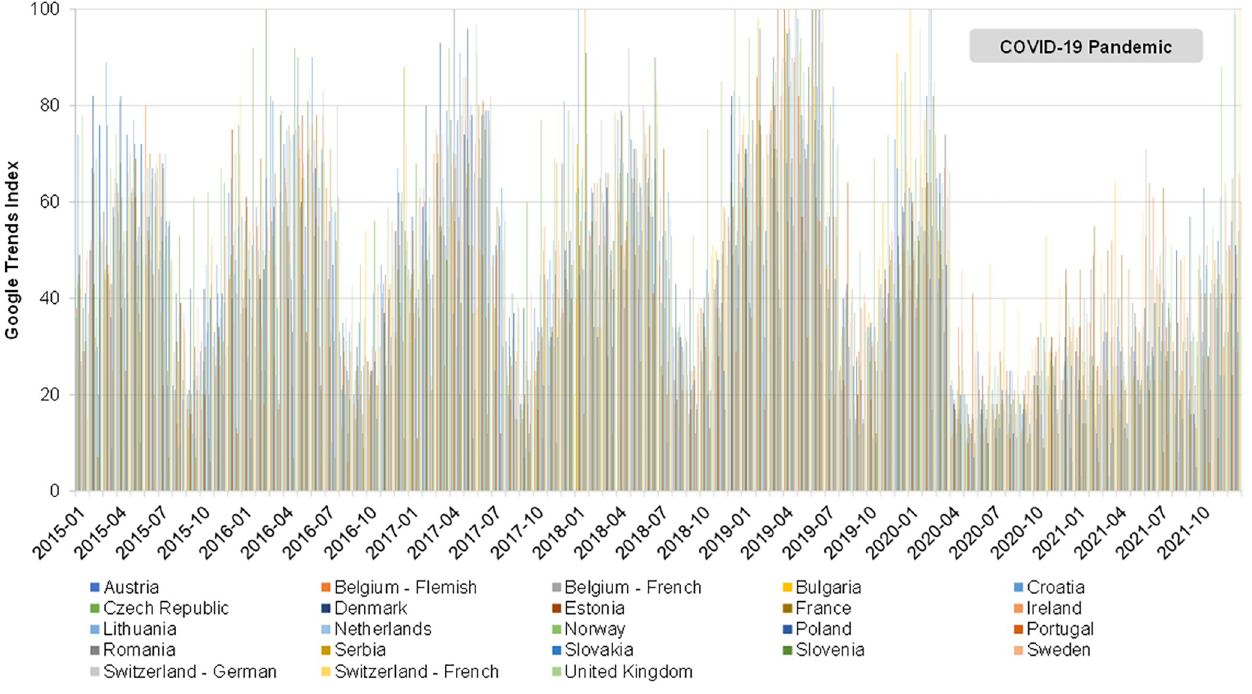
Fig 1. Monthly relative search query popularity of varicella keywords in European countries without universal varicella vaccination, 2015–2021. The Google Trends Index is calculated as the number of keyword searches divided by the total number of searches within a specific location and time period; it is standardized to range from 0 (no search activity) to 100 (peak search